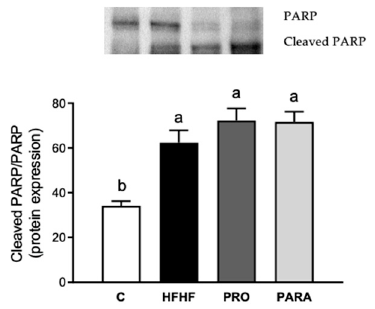
Figure 4 . Cleavage rate of PARP in liver samples of rats fed a control diet (C), a high-fat high-fruc- tose diet (HFHF) or a high-fat high-fructose diet supplemented with viable or heat-inactivated 10 9 CFU/day of Lactobacillus rhamnosus GG (PRO and PARA, respectively). Values are presented as mean ± SEM. Differences among the groups were determined by using one-way ANOVA, followed by the Newman–Keuls post hoc test. Bars not sharing common letters are significantly different ( p < 0.05). PARP: poly (ADP-ribose) polymerase.